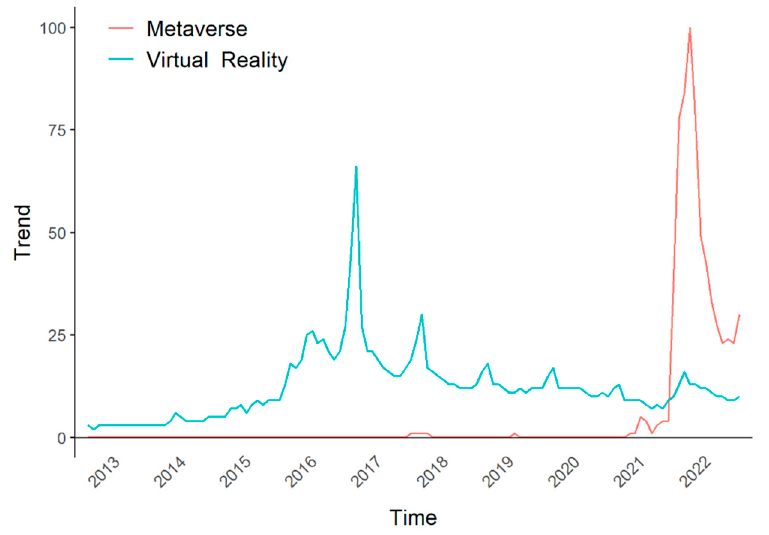
Figure 1. The results of Google Trends for ‘Metaverse’ and ‘Virtual Reality’ over time (2013 to 2022). The trends show the Virtual Reality boom in the mid-2010s and the recent emergence of the Metaverse.